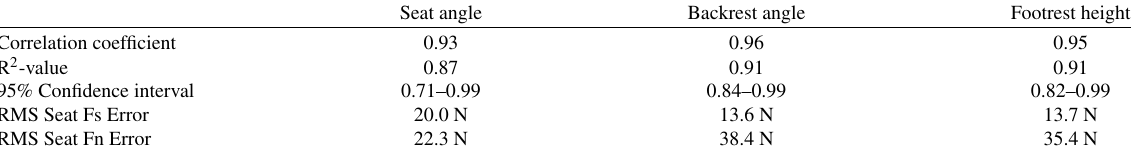
Table 2 The correlation coefficients, the confidence interval and the RMS error for the seat normal and shear force prediction for each of the three